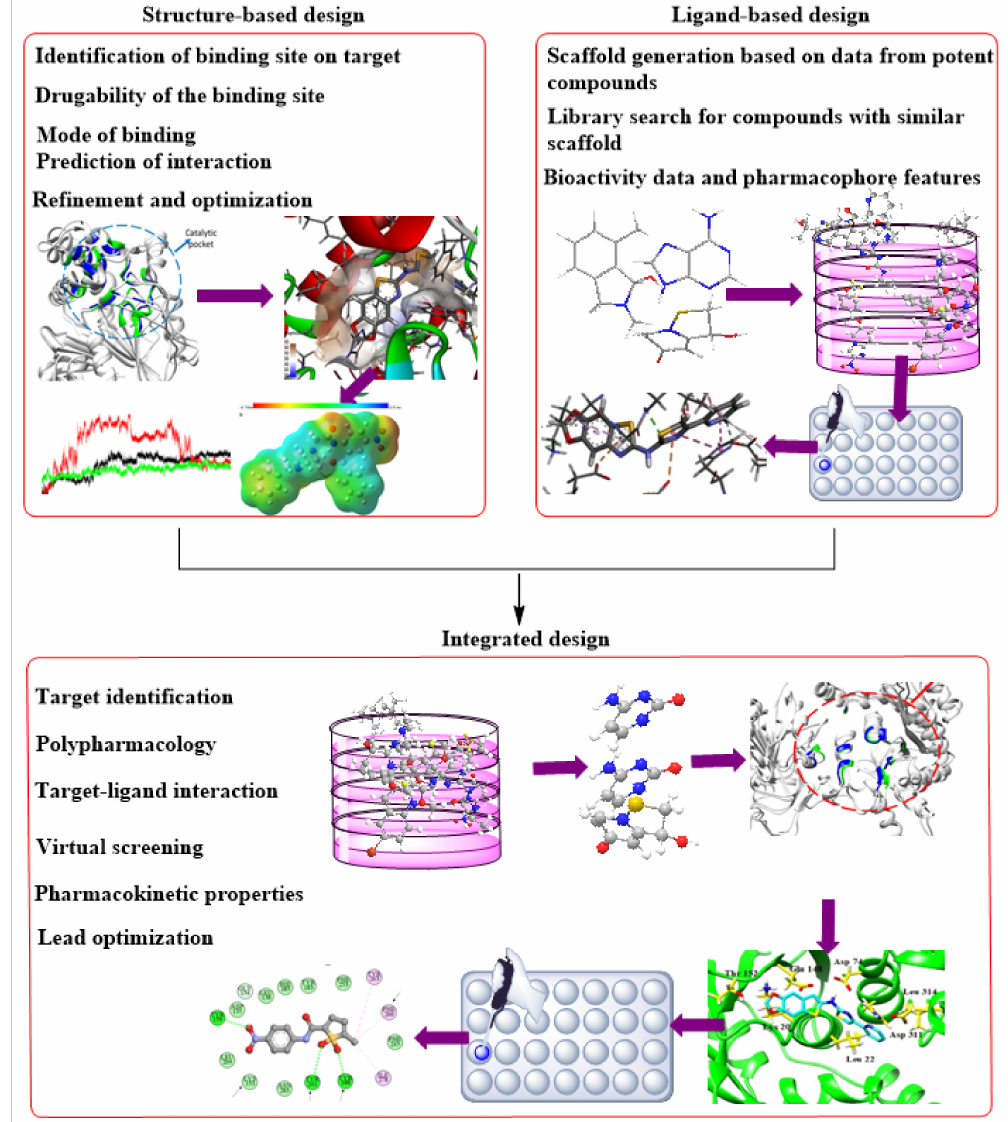
Figure 9. Complementary integration of Structure–Based Drug Design (SBDD) and Ligand–Based drug Design (LBDD)